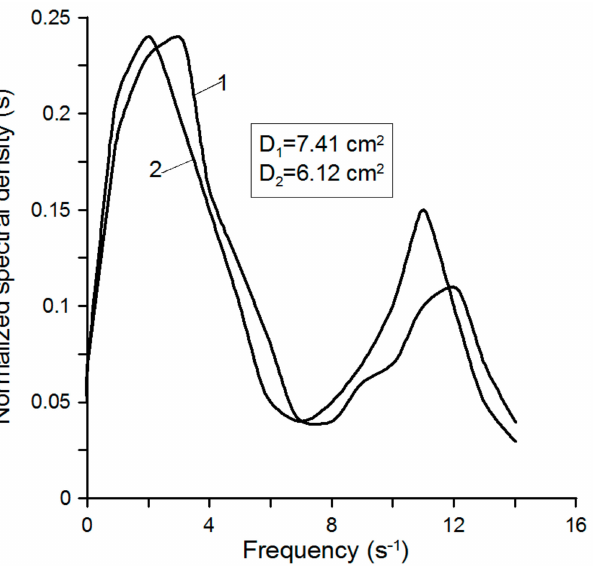
Figure 11. Normalized spectral densities of vertical oscillations of tractor’s front axle with (1) and without (2)